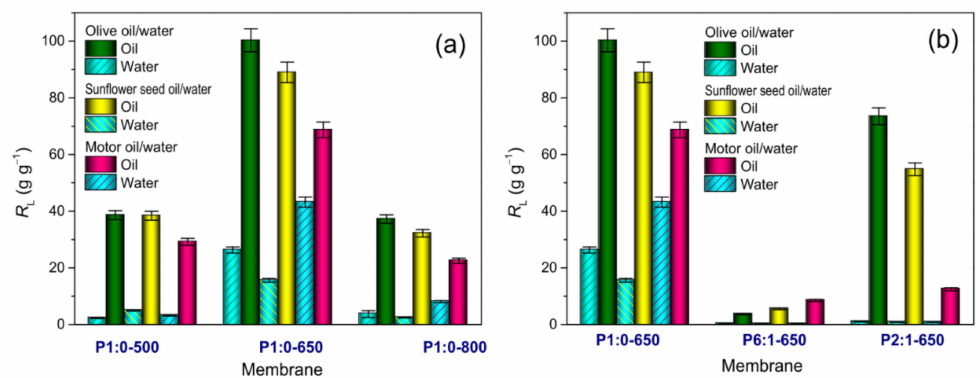
Figure 8. Liquid recovery efficiencies ( R L ) measured in spill tests: effect of ( a ) the carbonisation temperature of PAN-derived membranes, and ( b ) PAN:PMMA mass ratio of blend-derived membranes carbonised at 650 ◦ C. For an easier comparison, in the two plots, the same vertical scale is used.